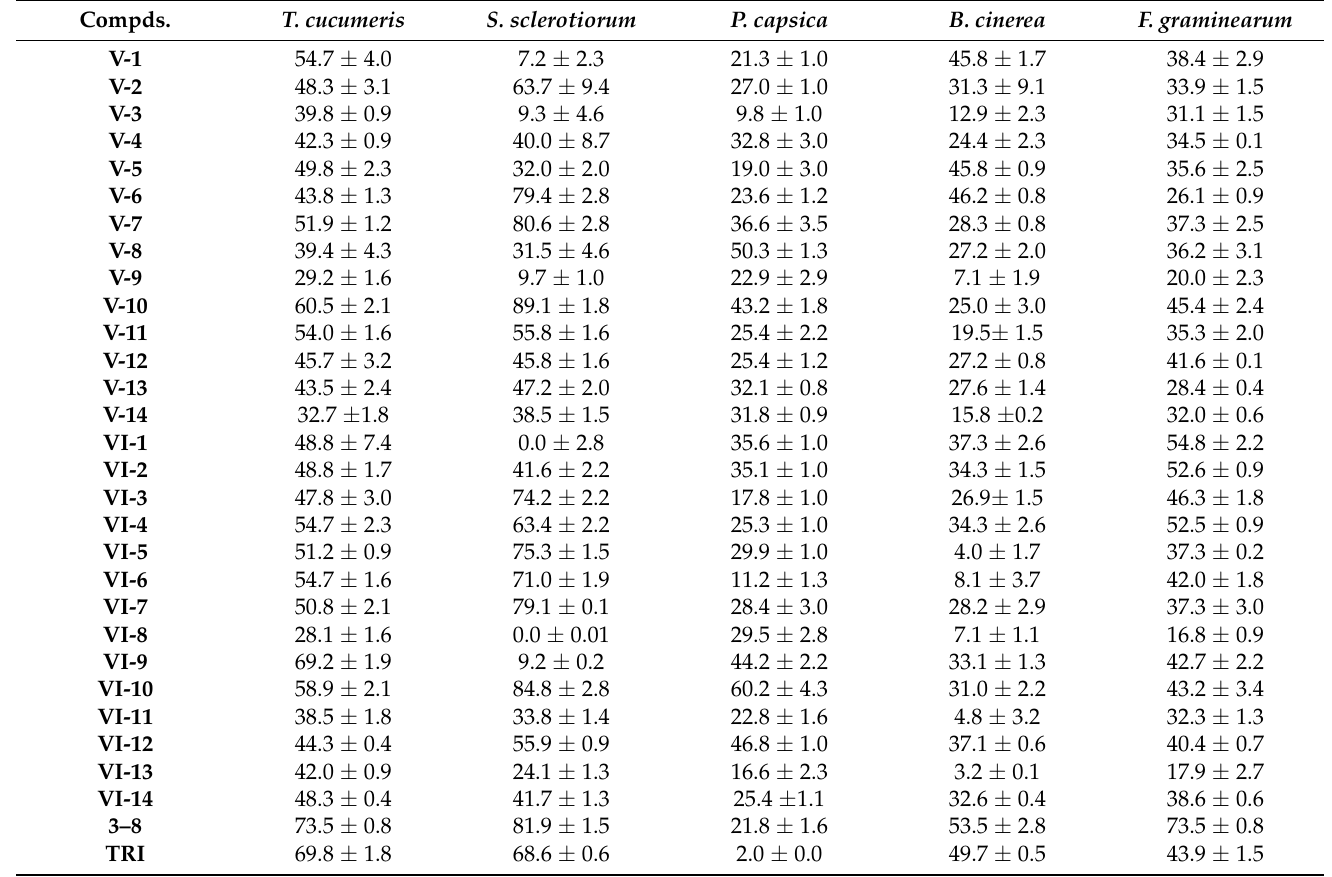
Table 1. The in vitro fungicidal activity of compounds V - 1 ~ VI - 14 at 50 mg/L (inhibition rate%, p < 0.05, n = 3).